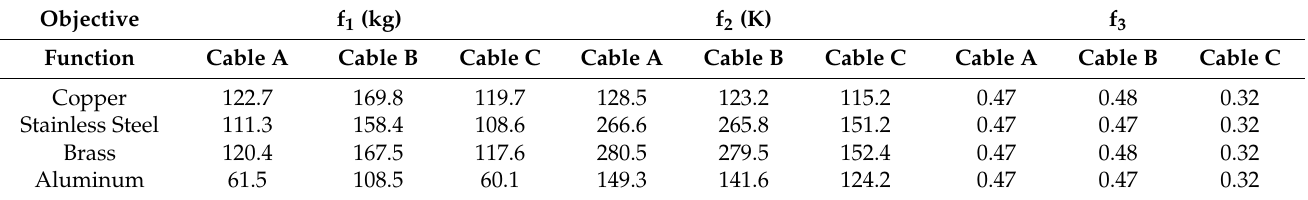
Table 5. The results of applying multi-objective optimization algorithms for designing a light, fault- tolerable, and reliable DC HTS cable in cryo-electric aircraft—Cable